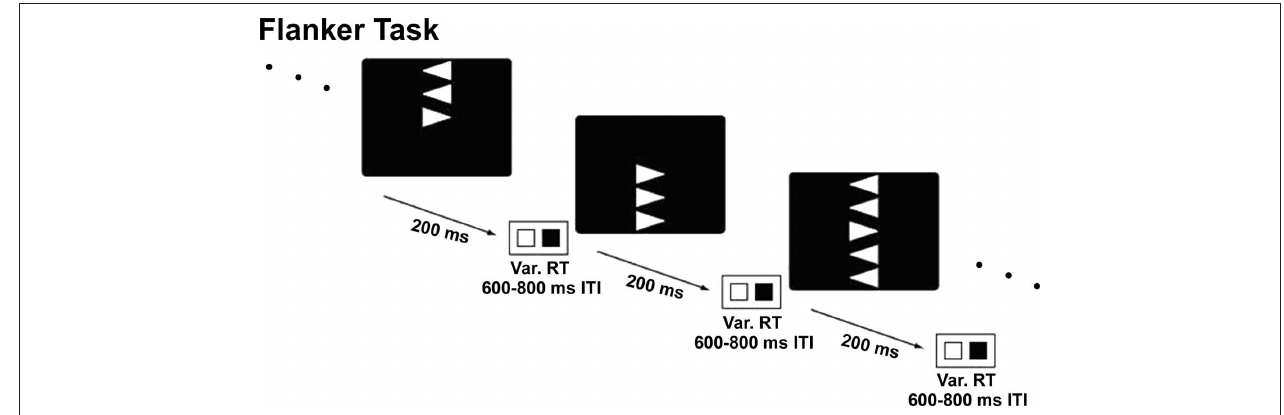
FiguRE 1 | Flanker task design. Participants responded to direction of the central arrow using a two-button response. Flanker arrows could be either congruent or incongruent and above, below, or both above and below the